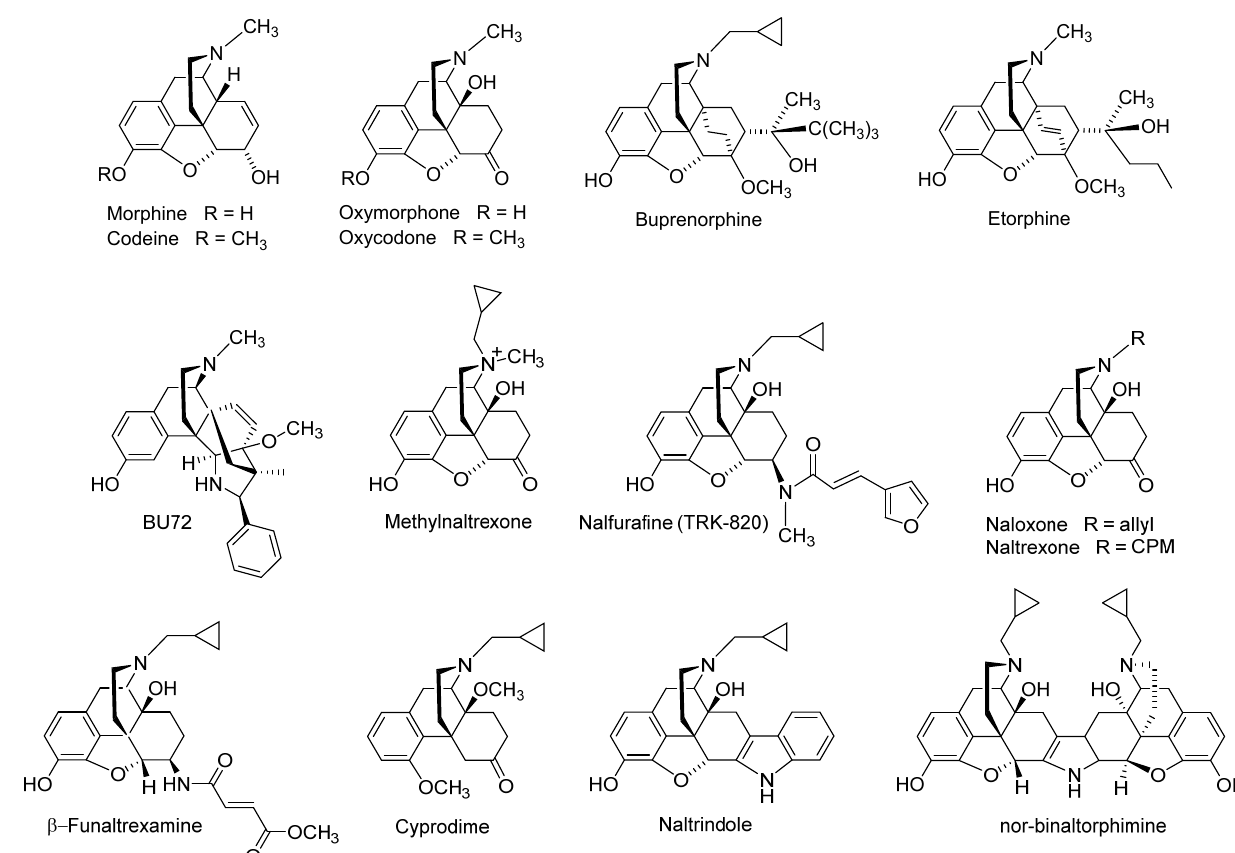
Figure 2. Examples of opioid morphinans used in the clinics or as research tools. CPM, cyclopropylmethyl.